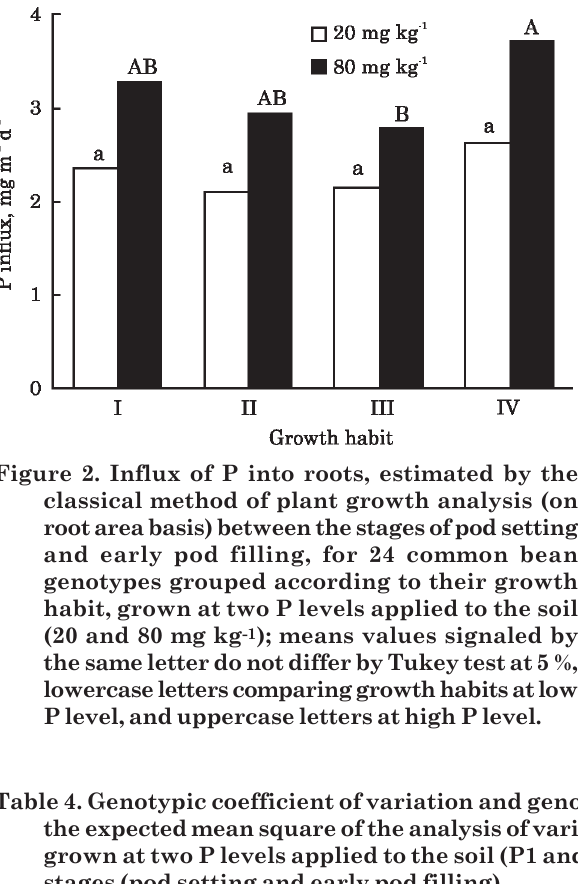
Table 4. Genotypic coefficient of variation and genotypic coefficient of determination, estimated based on the expected mean square of the analysis of variance, for traits evaluated in 24 common bean genotypes grown at two P levels applied to the soil (P1 and P2, respectively 20 and 80 mg kg -1 ), and at two growth stages (pod setting and early pod filling)